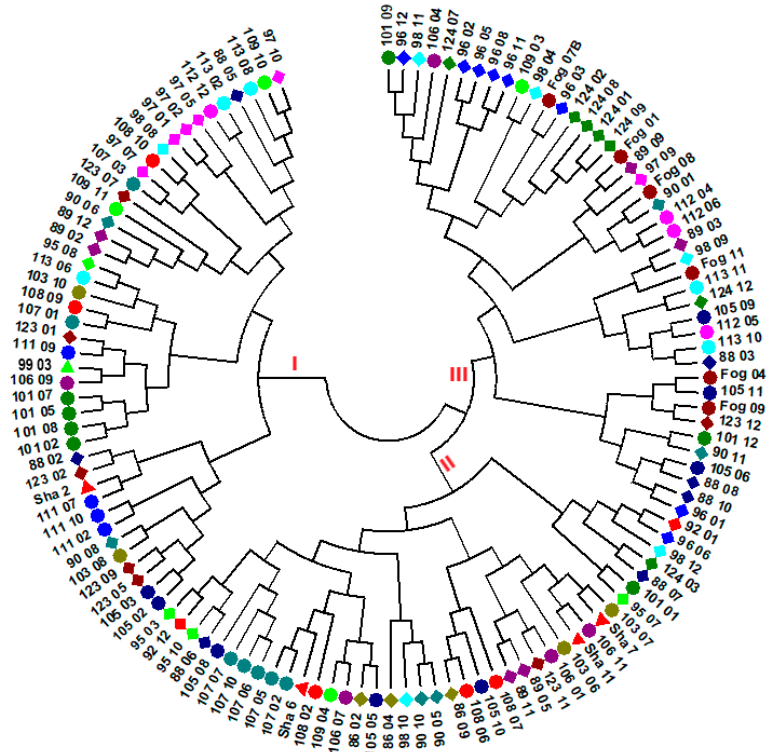
Figure 3. Neighbor-joining tree of 126 individuals representing the 24 accessions generated based on loci with a minor allele frequency of < 0.3, using evolutionary distances computed by the Tajima-Nei method (Tajima and Nei 1984). The individual samples were coded in a way that the first two or three digits / letters represent their accessions and the last two-digit numbers represent the codes for the plant in that accession. The accession names are given without the two initial letters (NG), and Fog and Sha represent Fogera and Shambu, respectively. Individuals represented by the same shape and color belong to the same accession.